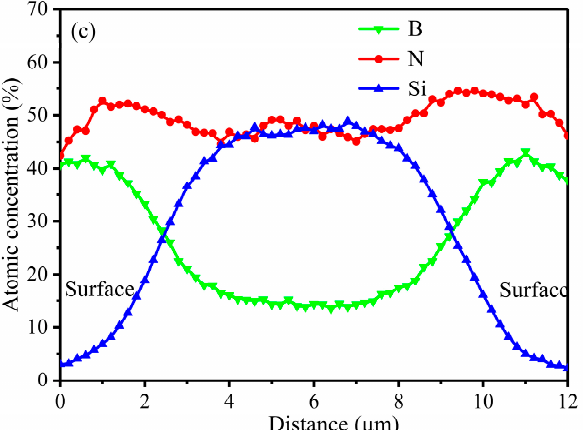
Figure 7. Elemental concentration of B, N and Si along the composite fiber diameter: ( a ) P1-F; ( b ) P2-F; ( c ) P3-F.